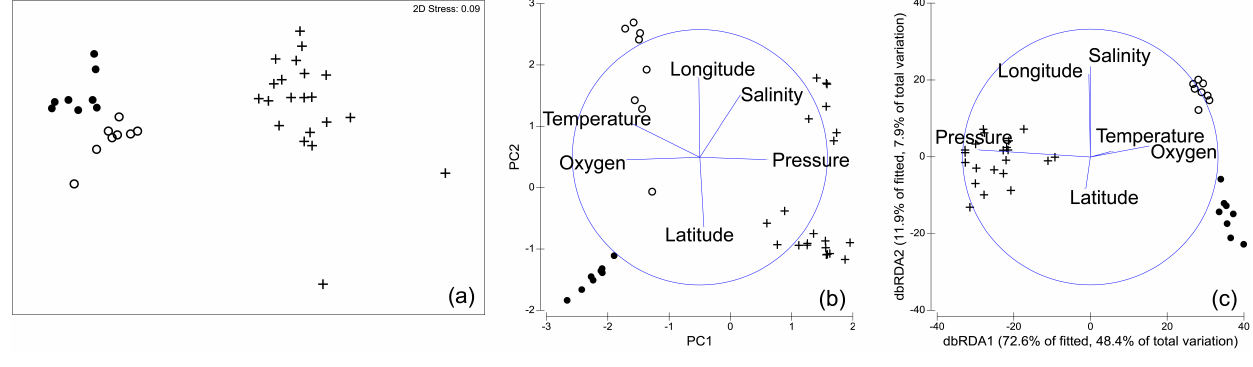
Fig. 3. Distribution of the bacterial communities in the epi- and bathypelagic waters according to biotic and environmental data. (a) Non- metric multidimensional scaling (NMDS) results based on qualitative ARISA fingerprinting showing a sharp clustering of epi- (open and filled circles corresponding respectively to eastern and western epipelagic samples) and bathypelagic (crosses) seawater samples. (b) Principal component analysis performed on the environmental data reported in Table S1 (Supplement). (c) dbRDA ordinations of the presence/absence of the ARISA dataset overlaid with the partial correlations of the tested environmental variables explaining the clustering of epi- (open and filled circles) and bathypelagic (crosses) seawater samples.